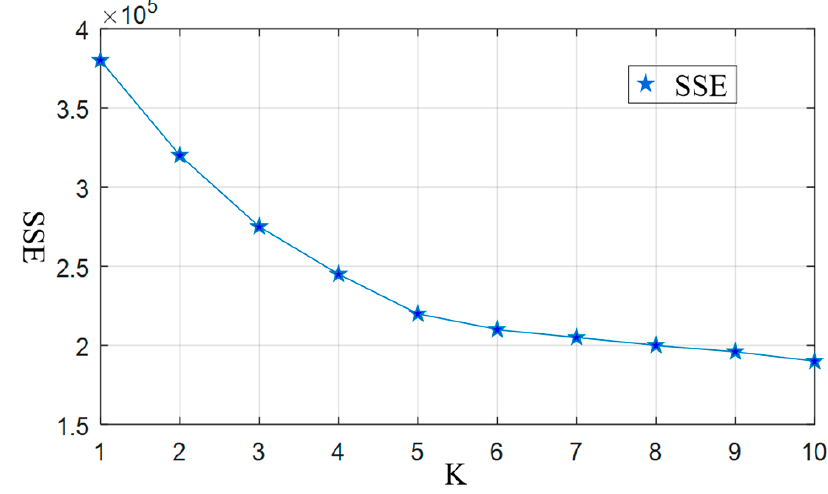
Figure 6. Relationship Curve Between Driving Style Cluster Number and SSE.